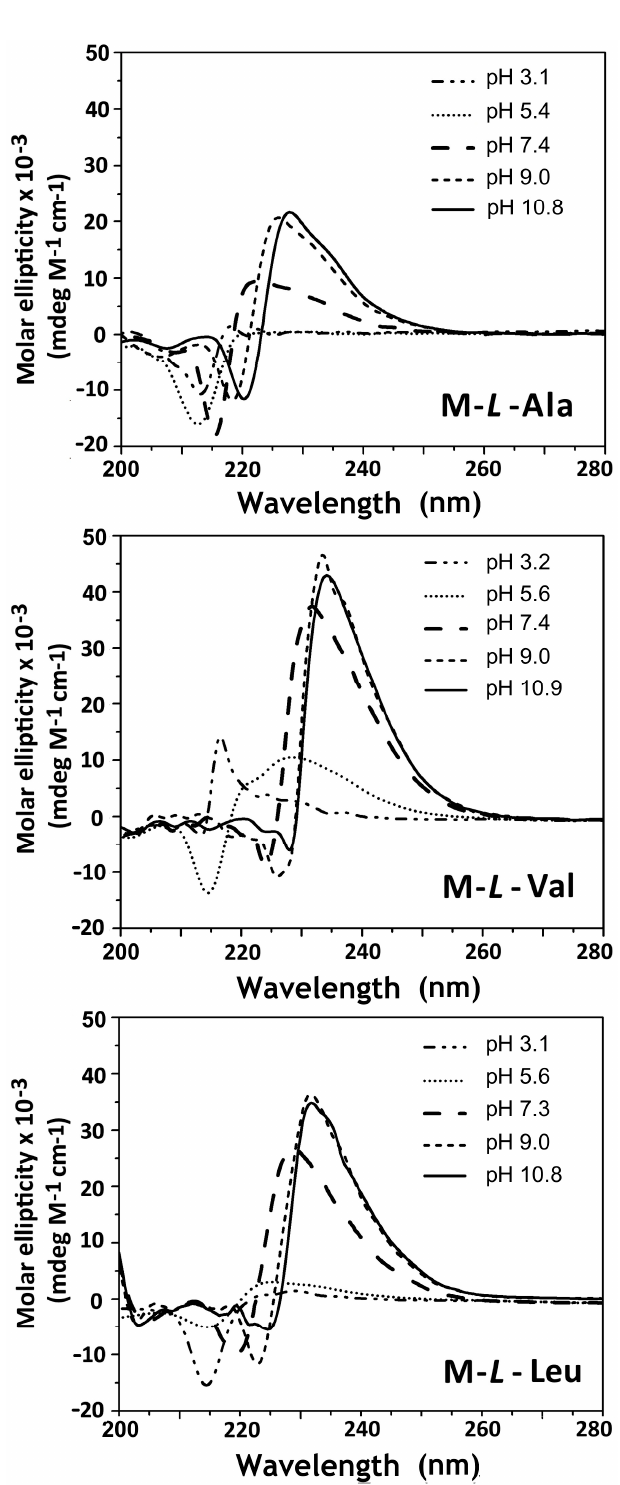
Figure 3. pH Dependence of PAAC CD spectra. Operational conditions: 1.83 ± 0.17 mM repeating units in 0.1 M NaCl solution, 25 °C. For the sake of clarity, some curves have been omitted and reported in Figure S5.